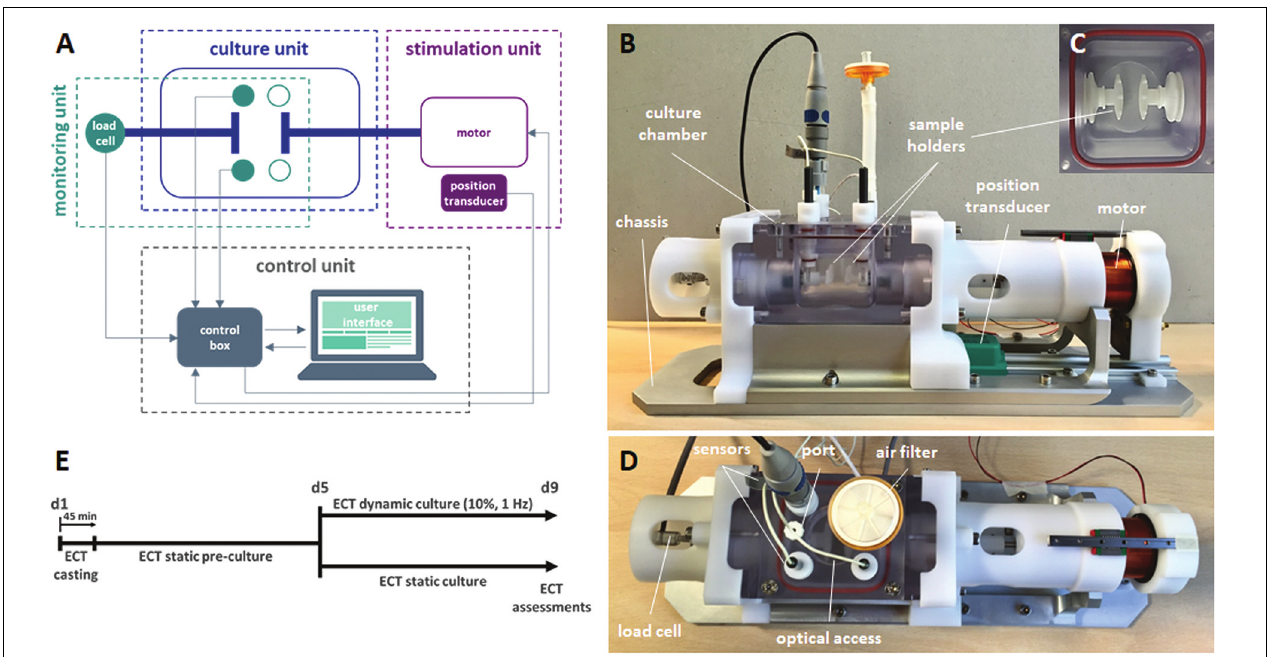
FIGURE 1 | Bioreactor platform and experimental plan. (A) Scheme of the connections among the bioreactor units: culture, stimulation, monitoring, and control units. (B) Lateral view of the bioreactor platform showing the chassis, the culture chamber, the sample holders, the position transducer, and the motor. (C) Top view of the sample holders within the culture chamber. (D) Top view of the bioreactor platform showing the load cell and, on the culture chamber lid, the sensors, the medium sampling/replacement port, the air filter, and the optical access. (E) Experimental plan of the ECT culture, showing the static pre-culture time up to day 5 (d5) and the following culture in either dynamic or static condition up to day 9